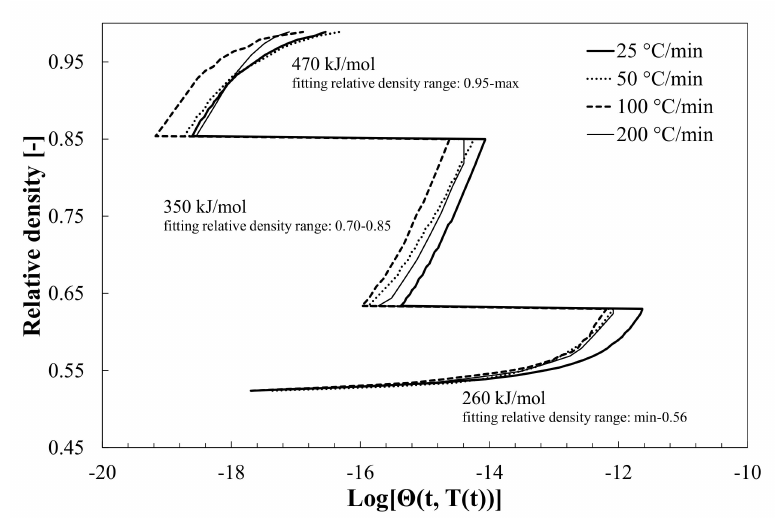
Figure 6. Master sintering curve with corresponding apparent activation energy for spark plasma sintering of Mg-doped alumina. Due to extensive viscous flow in the intermediate sintering stage, confirmed by a stress exponent analysis, the predominant mechanisms change during the